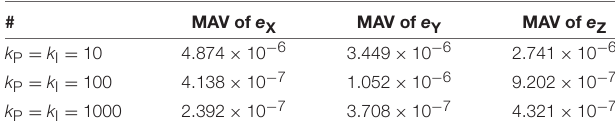
TABLE 1 | Maximal absolute value (MAV) of Cartesian error synthesized by the proposed NTOA scheme (6) with zero noise considered and with different k P and k I values